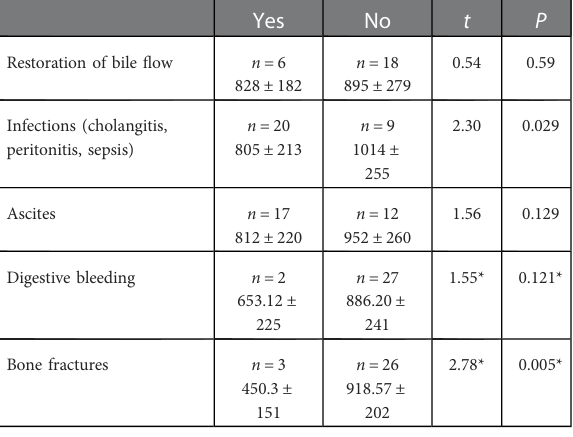
( Table 4 ). There were no differences with the type of graft (deceased or living donor, P = 0.114), type of bile duct (single or double, P = 0.254), risky vascular anastomosis ( P =